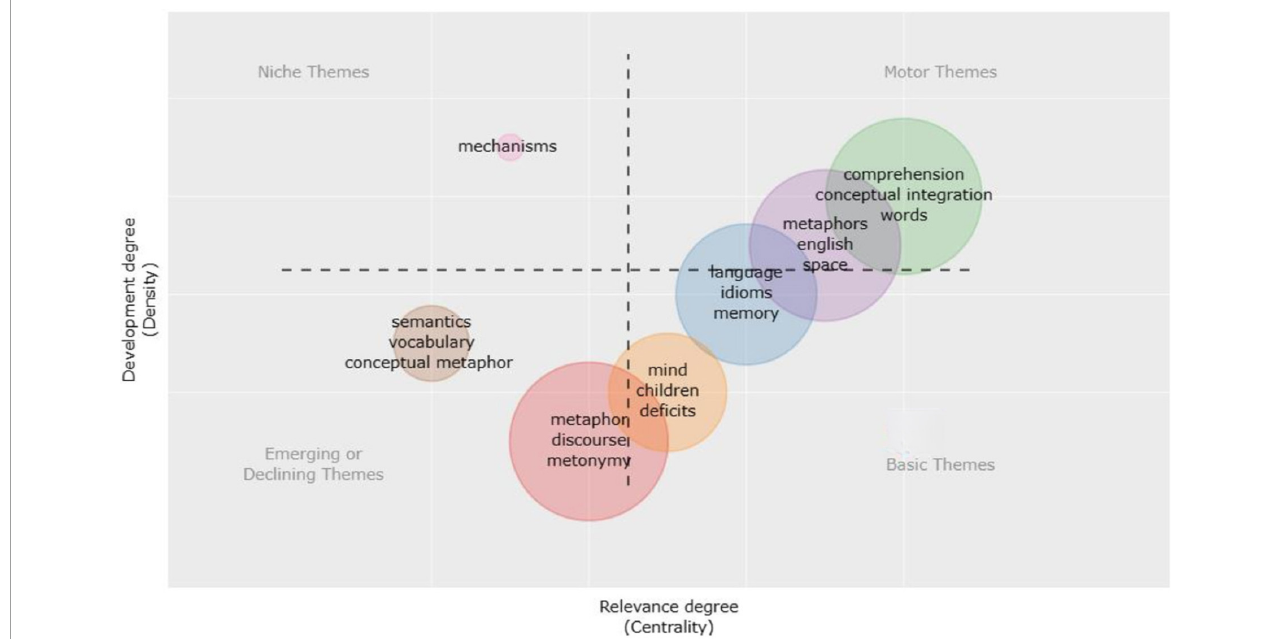
FIGURE6 Thematic map.